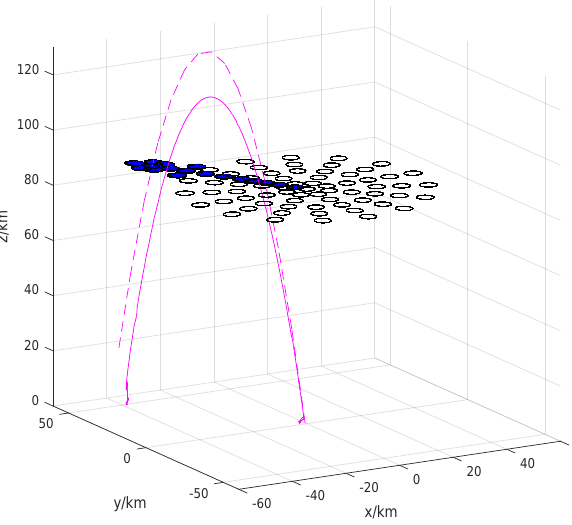
Figure 1. Geometry of MAARSY measurement setup. The circles show single beams’ positions at 85km altitude. Filled blue cir- cles show 17 additional beam pointing directions for the WADIS-1 launch. The thin dashed magenta line shows the predicted rocket trajectory. The solid magenta line shows the actual rocket trajec- tory.